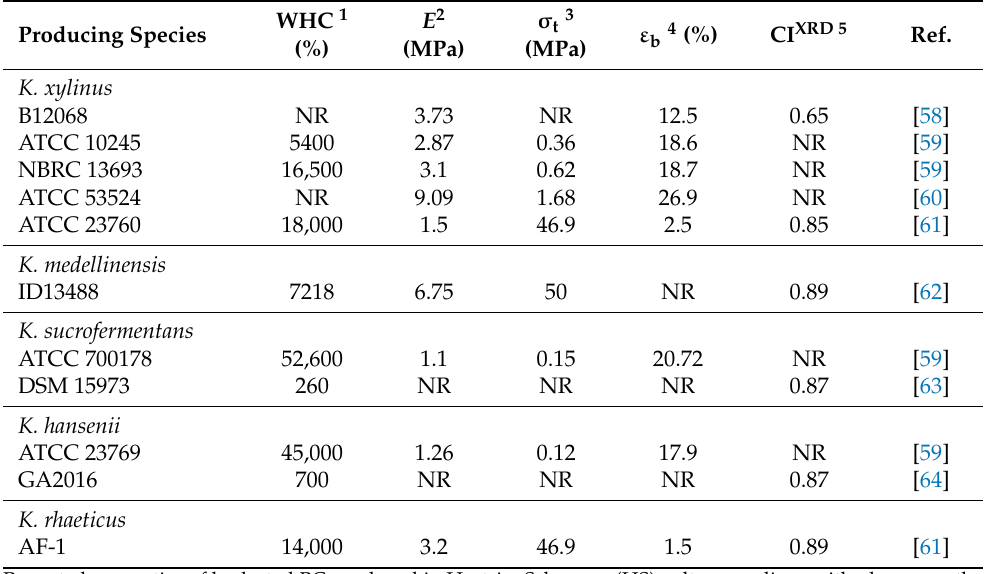
Table 2. Mechanical and material properties of BC produced by different Komagataeibacter strains. WHC 1 Producing Species